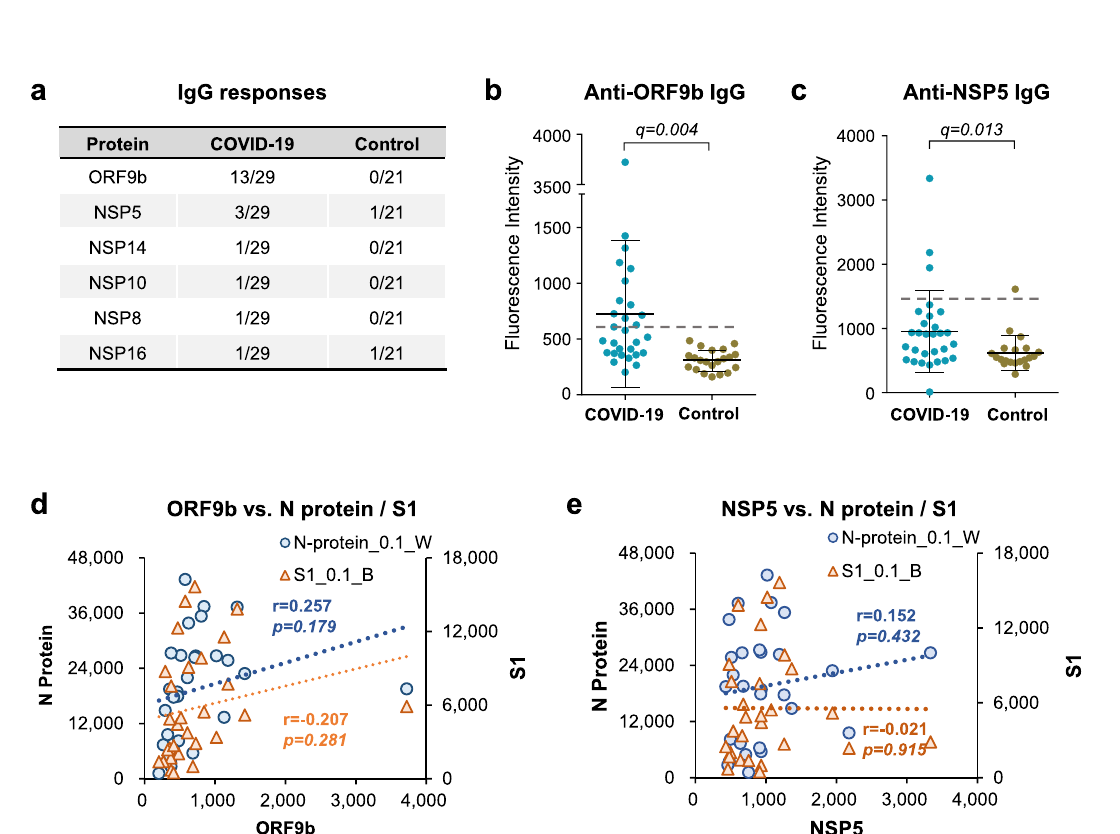
Fig. 6 IgG response to other SARS-CoV-2 proteins. a Other SARS-CoV-2 proteins that were recognized by IgG from the convalescent sera, in comparison to that of the controls. b , c Anti-ORF9b IgG ( b ) or anti-NSP5 IgG ( c ) in the patient and control group. For b , c , each dot indicates one serum sample either from the convalescent group ( n = 29) or the control group ( n = 21). Data are presented as mean values ± SD. The dashed line indicates cutoff value calculated as mean + 3x SD of the control group. P- values were calculated by the two-sided t- test and q -values were adjusted p- values using BH method. d , e Correlations of the overall IgG responses for N or S1 protein vs. ORF9b ( d ) or NSP5 ( e ). For d , e , each dot indicates one serum sample from the convalescent group ( n = 29) and p- values were calculated by the two-sided t- test.